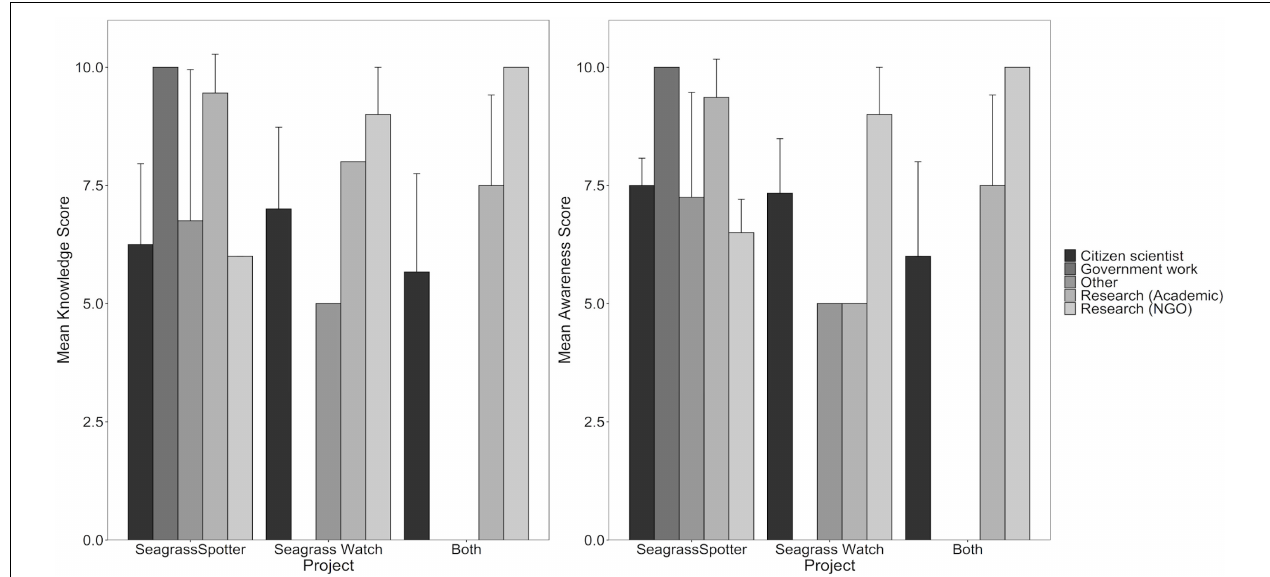
FIGURE 2 | Mean scores and standard deviation of perceived knowledge of seagrass ecosystems (left) and their threats (right) between current participants of SeagrassSpotter, Seagrass-Watch or both projects. Sample sizes by nature of interaction with seagrasses (in order of legend): SeagrassSpotter n = 4,1,4,11,2; Seagrass-Watch n = 3,0,1,1,3; Both n =